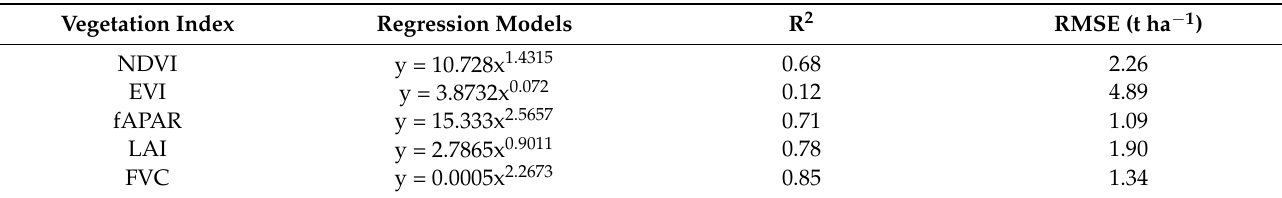
Table 2. Regressions of wheat biomass on Sentinel 2A vegetation